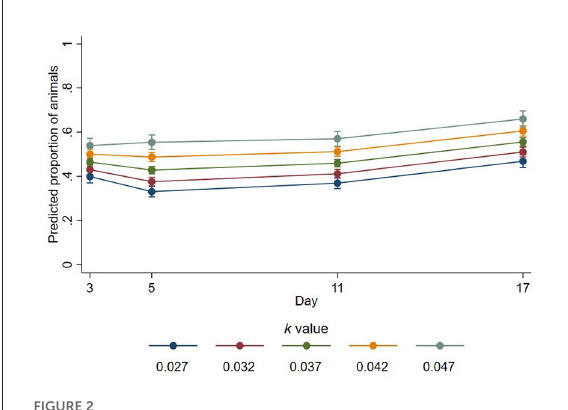
FIGURE2 Predicted proportions of lying animals that had outstretched legs at different k -values across days. Error bars represent 95% confidence intervals of predicted proportions. Predicted proportions were calculated as predicted numbers divided by the average number of sheep lying at each time point (12.48).